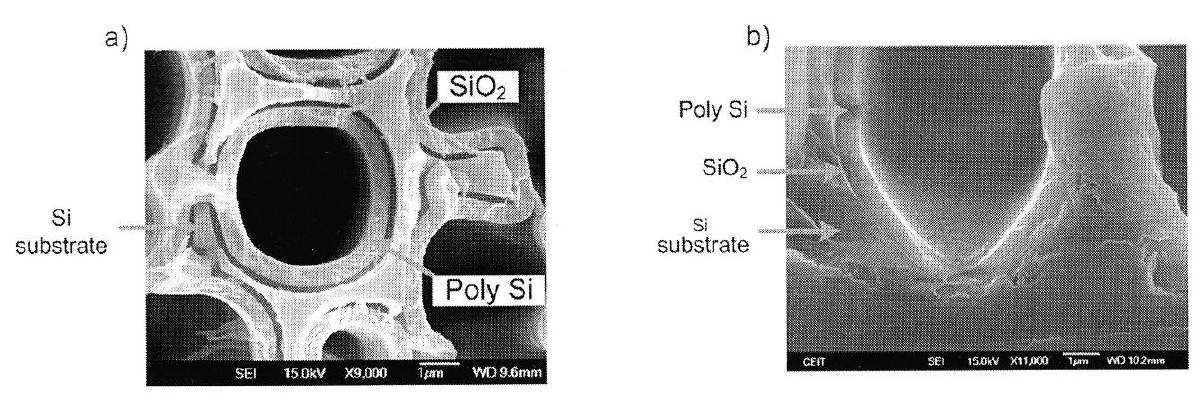
Figure 3. Scanning electron micrographs showing (a) a plan view macropore covered by a layer and a deposited polysilicon layer acting as top electrode and (b) the SiO 2 corresponding cross-sectional view (image taken from